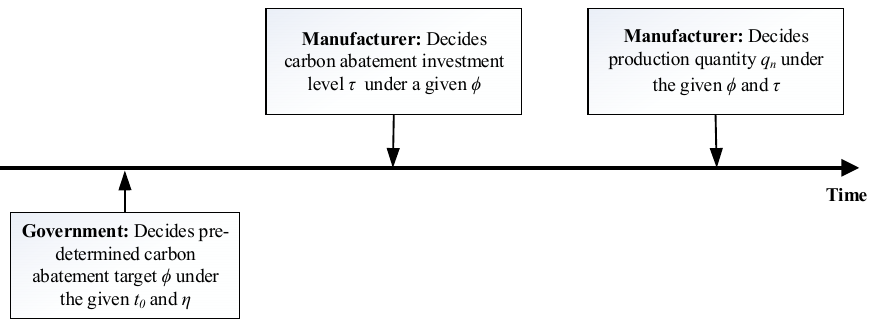
Figure 1. Sequence of participants’ decisions.